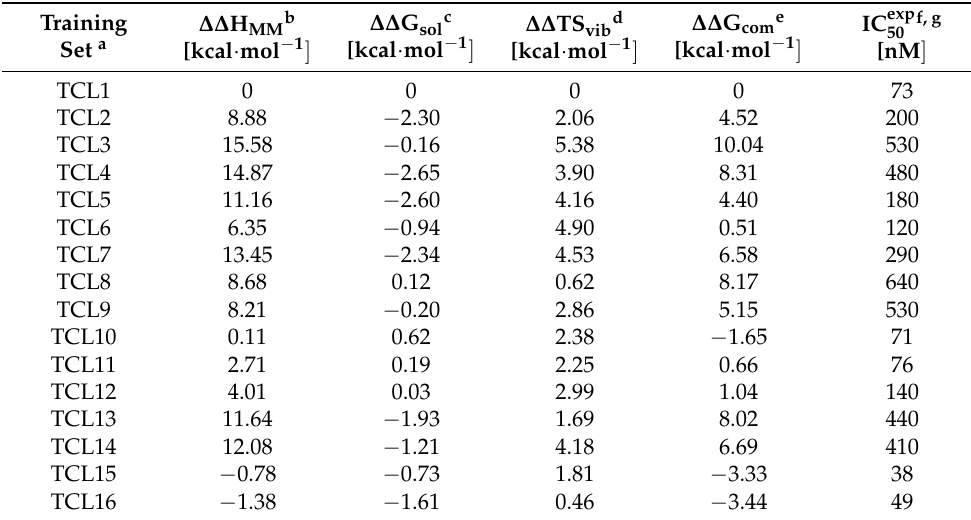
Table 2. Relative complexation Gibbs free energy (binding affinity, rGFE) and its components for